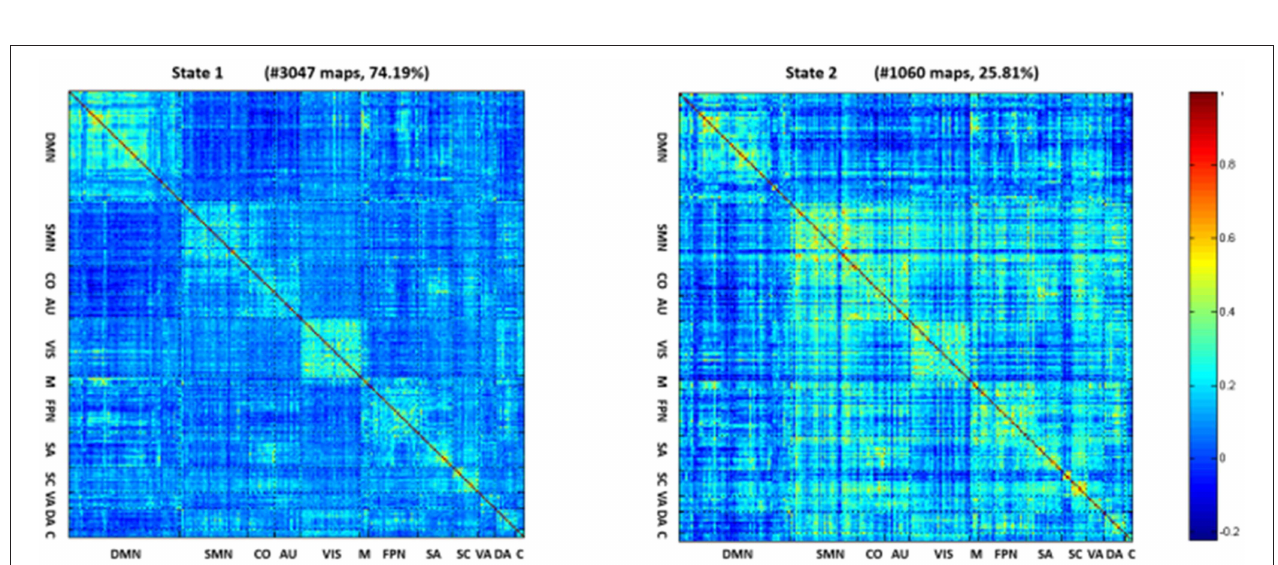
FIGURE 1 | Dynamic functional network connectivity characteristics. Illustration of the statistical analysis results of the dFCV between DLB and HC. (A) Depicts the dFCV difference matrix. Red dots represent an increase of variation in the DLB group, while blue dots represent a decrease of variation in the DLB group. (B) A 3D visualization of the results in (A) ( p < 0.005).